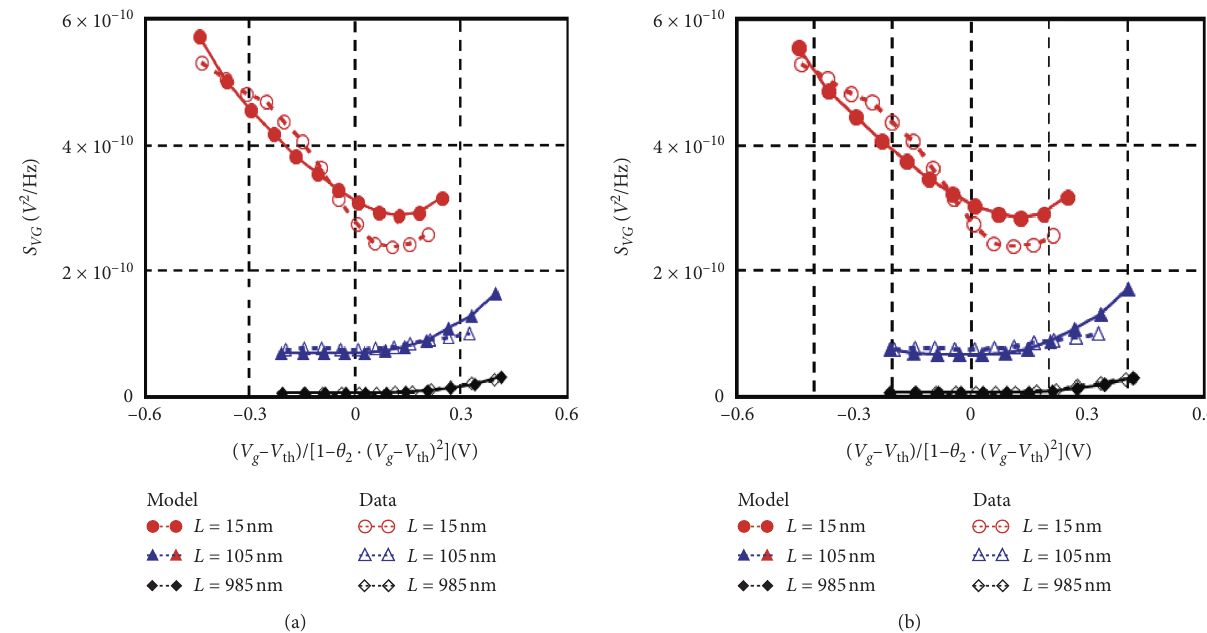
Figure 8: Comparison of experimental plots of S results, with RCS parameters, and with (b) CNF+CMF+ Δ r , semianalytical model results for advanced FDSOI samples, with some effective gate lengths.